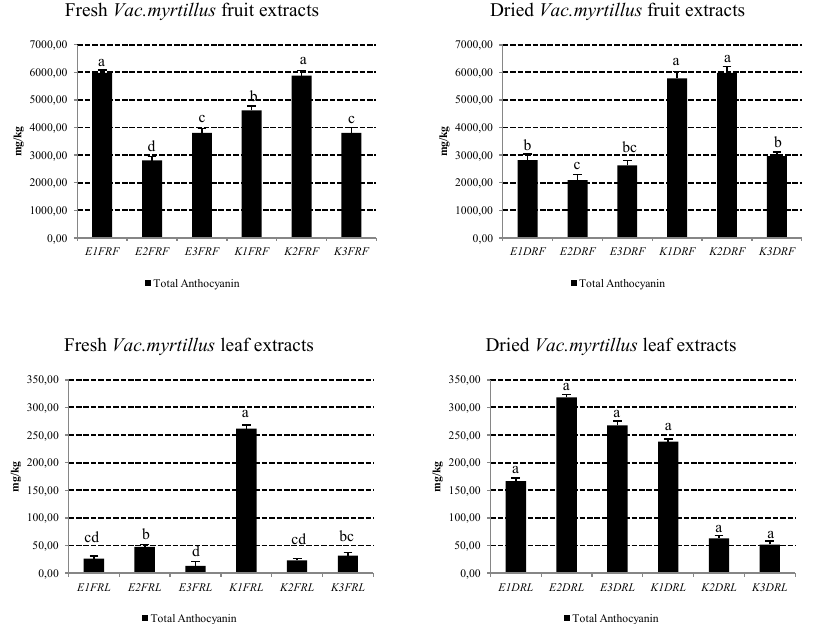
Fig. 2: Total anthocyanin (TA) contents (mg/kg) of fresh and dried Vac. myrtillus fruit and leaf extracts ( E : Erdek, K . Kapıdağ, FR : Fresh, DR : Dried, F : Fruit, L : Leaf, 1-3: Codes of samples collected from different regions, Total anthocyanins were expressed as cyanidin-3-glucoside equivalents, Different letter(s) on bar indicate statistically significant differences, p <0.05)